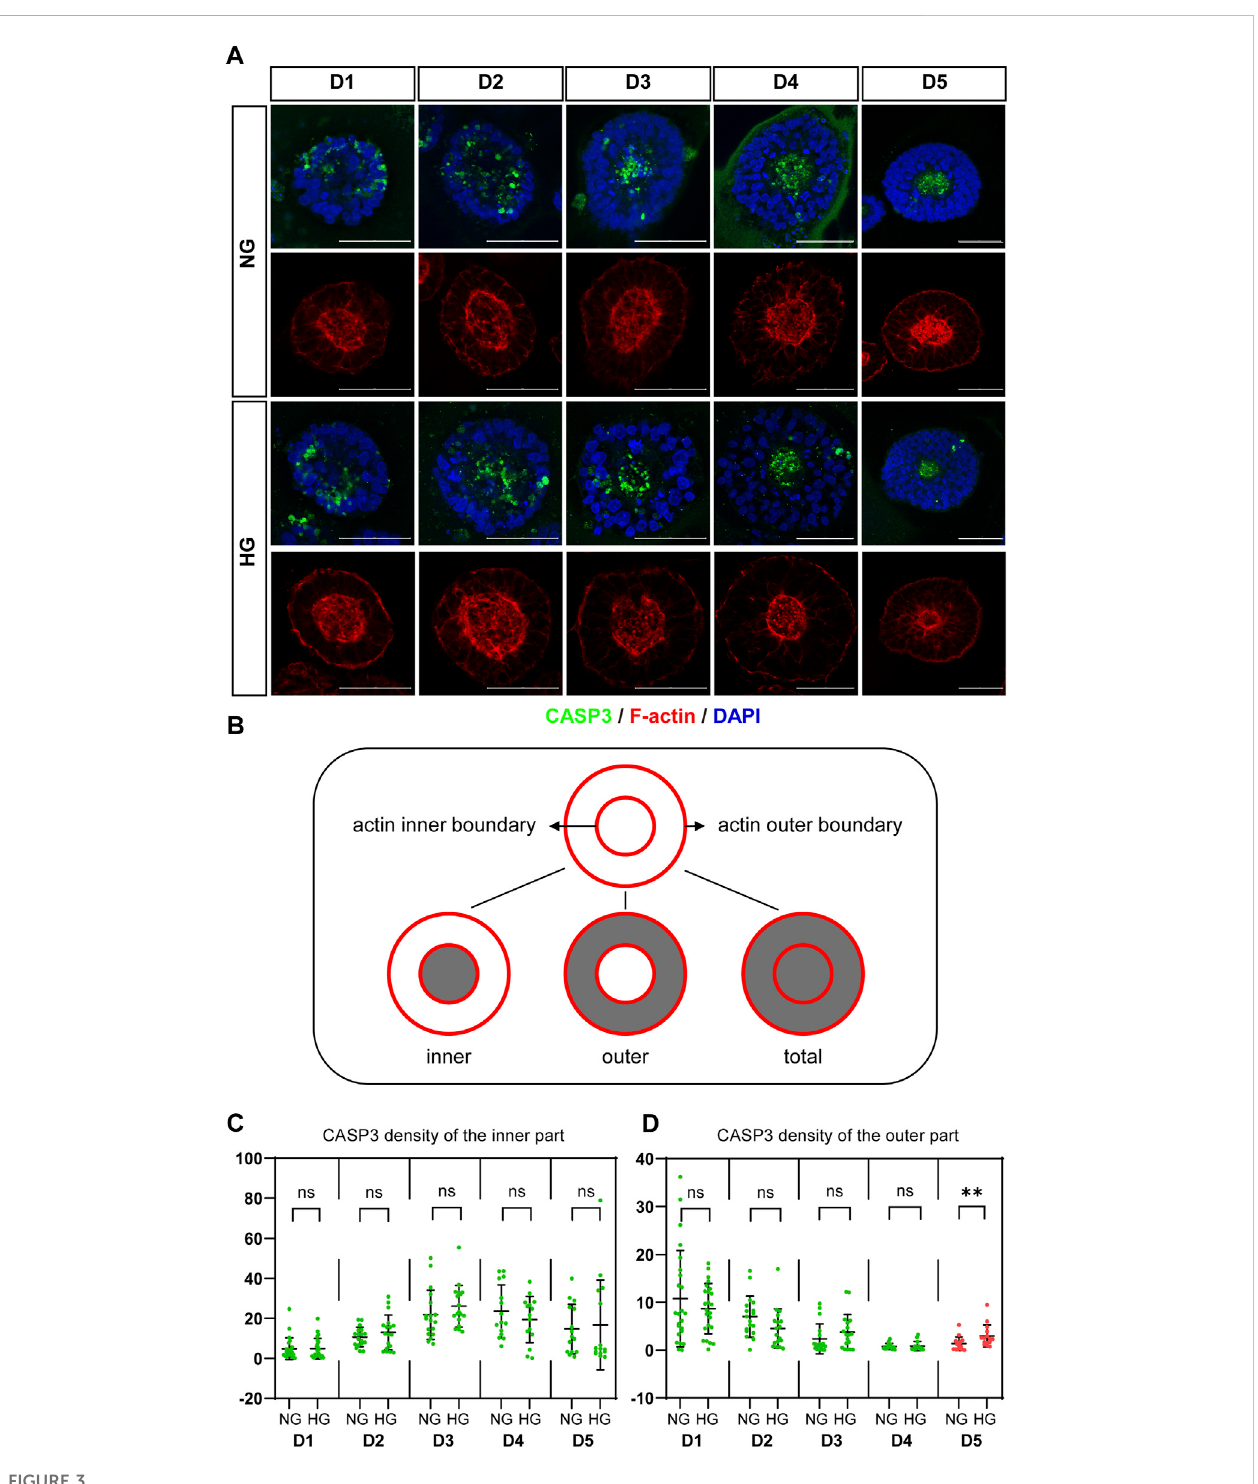
FIGURE 3 High glucose increases the apoptosis at the end of 3D model culture. (A) Double immuno fl uorescence images from CASP3 (green) and F-actin (red) in thenormal (NG)and 2xhighglucose(HG)groupsinD1-5.DAPI(blue) showsthenucleus. Scalebaris50 μ m. (B) IllustrationofF-actinstained images.The red lines represent the actin inner and outer boundaries. The area enclosed by actin inner boundary is named “ inner ” area. The area enclosed by actin outer boundaryisnamed “ total ” area.The “ outer ’ areaisthetotalareasubtractedtheinnerarea,whichisoccupiedbycells.CASP3densityintheinner (C) orthe outer (D) areas of the 3D models at D1-5 were calculated. N ≥